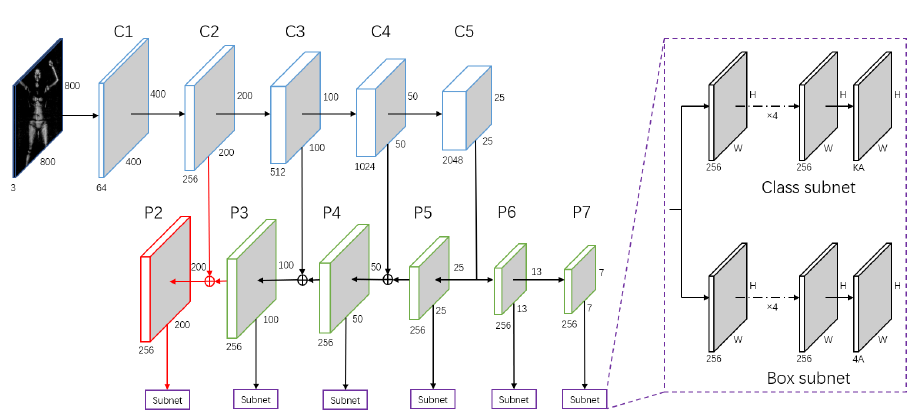
Figure 4. Network structure of modified RetinaNet. C1–C5 represent the resnet-50 feature extraction structure, and P2 to P7 represent the feature pyramid structure. Each layer of feature pyramid is followed by a